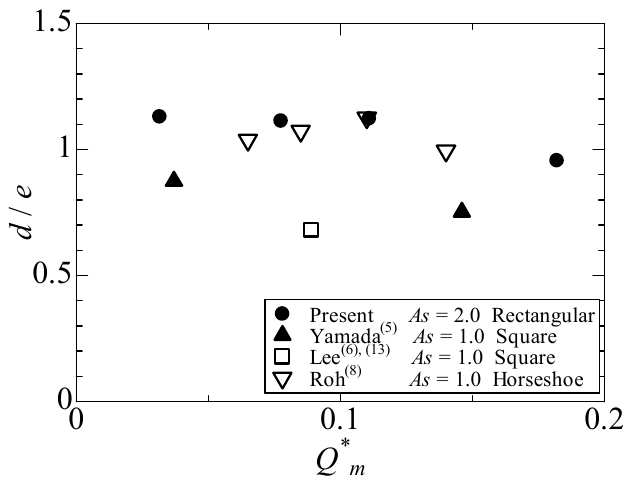
Fig. 11 Relationship between Q * m and d /